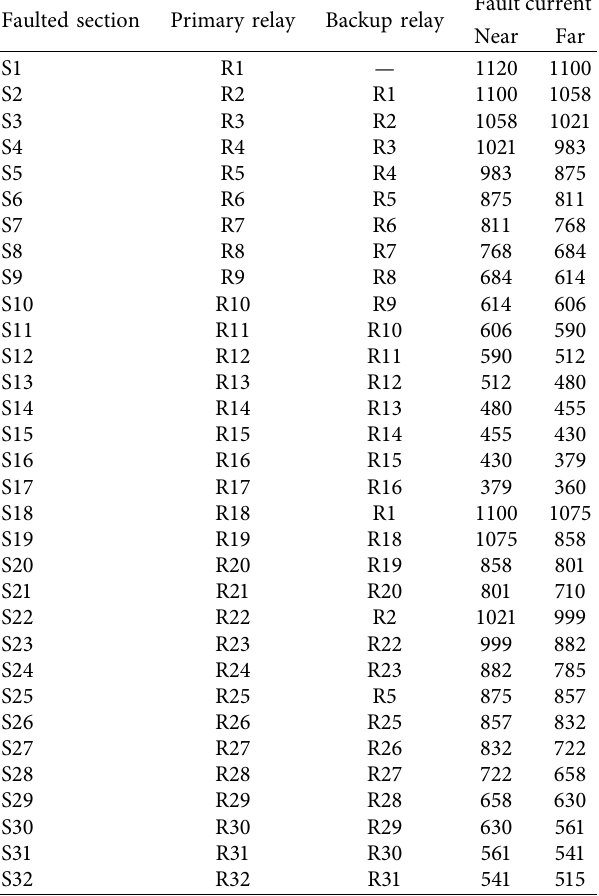
primary relay. Faulted